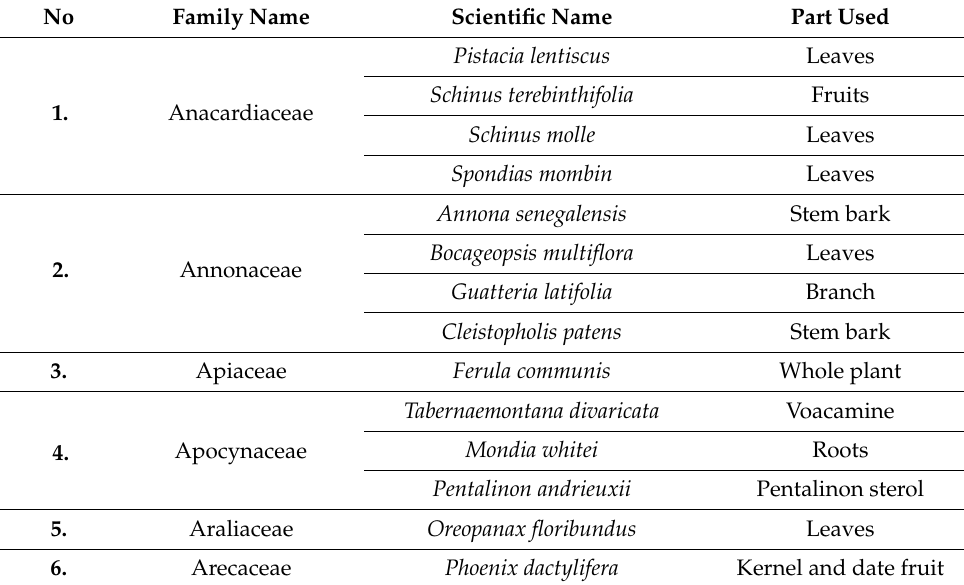
Table 2. Botanical characteristics of the medicinal herbs in the present